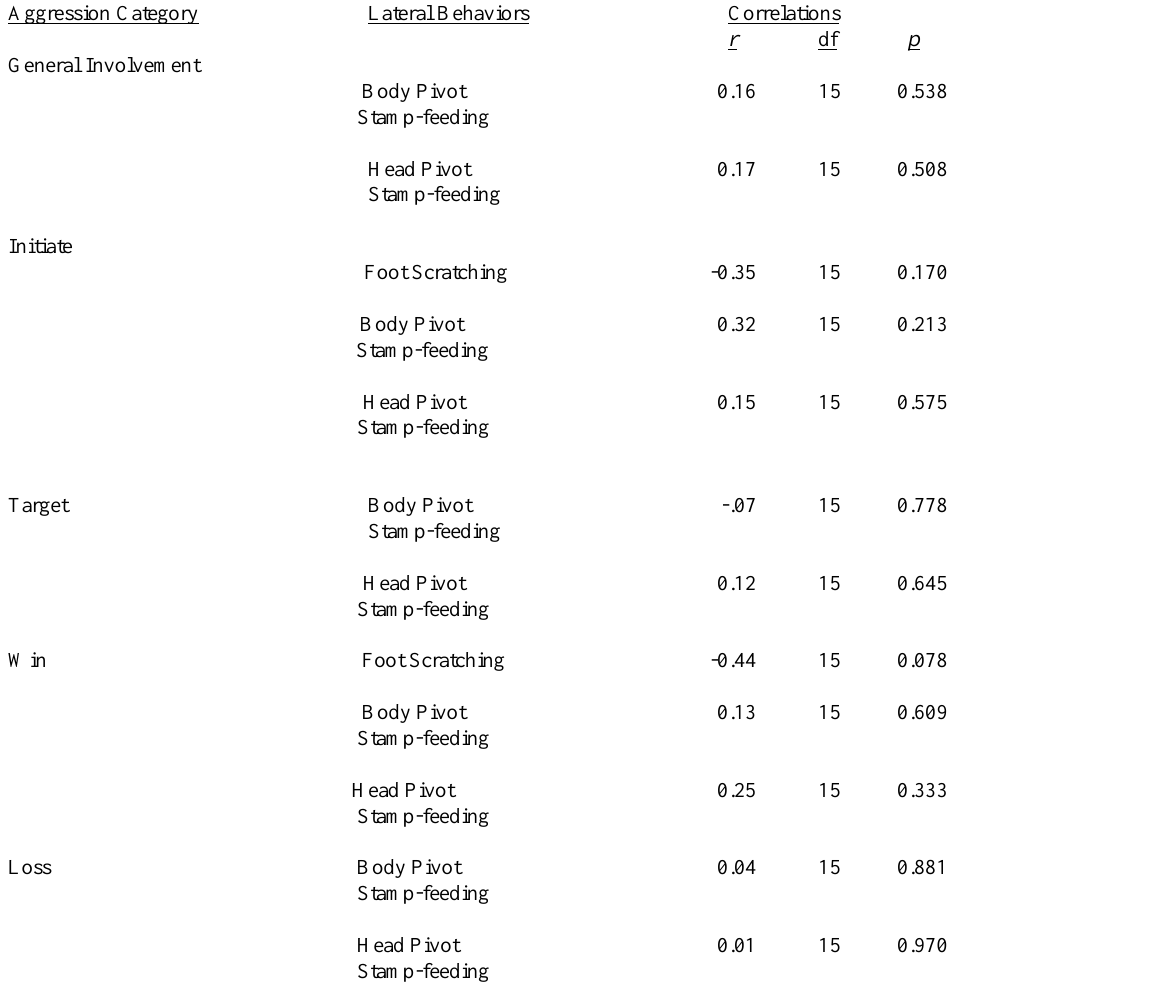
Table 3 Aggression Categories and Lateral Behaviors Aggression